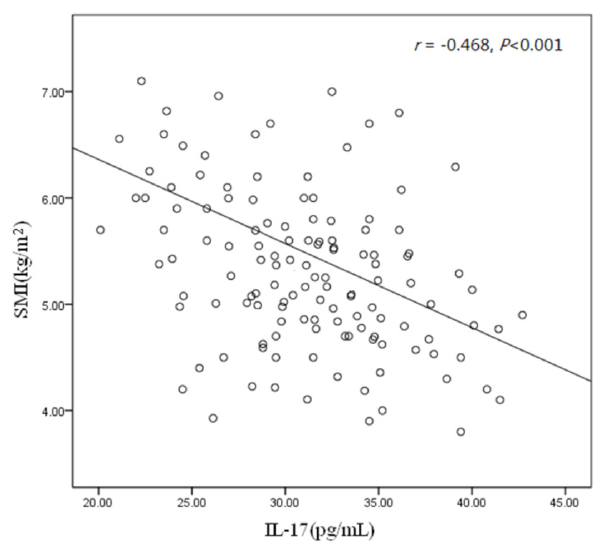
Scatter Fig. 2. Correlation between SMI and serum IL-17. Scatter plot 3. indicates a negative correlation between SMI and serum IL-17 levels (r= -0.468, P <0.001).